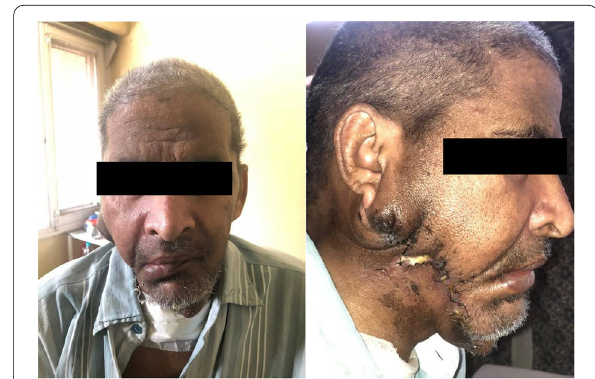
Fig. 4 Post-operative image of the patient showing full recovery from large-size tumor